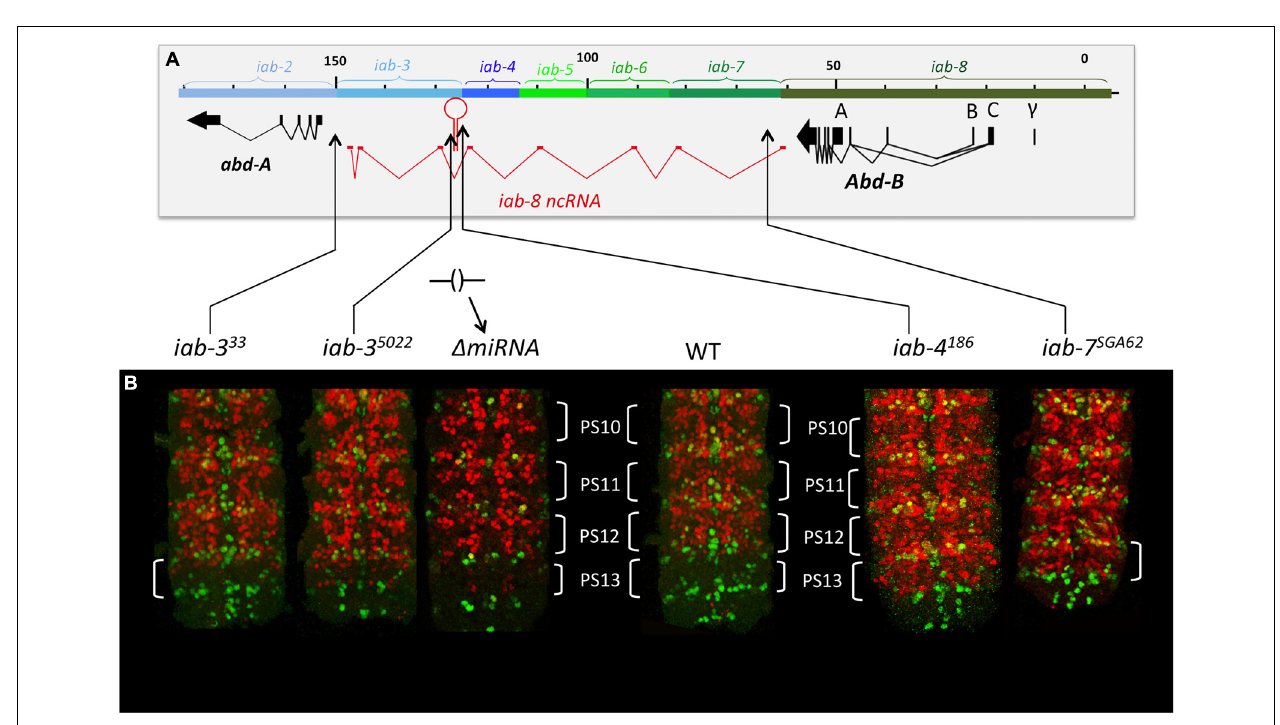
de-repressed in only few neurons in PS13. Panel C show the abd-A (red) and Abd-B (green) expression patterns inWT and Fab-8 64 homozygotes. Note the complete de-repression of abd-A in PS13 (original observation published in Gummalla etal., 2012).